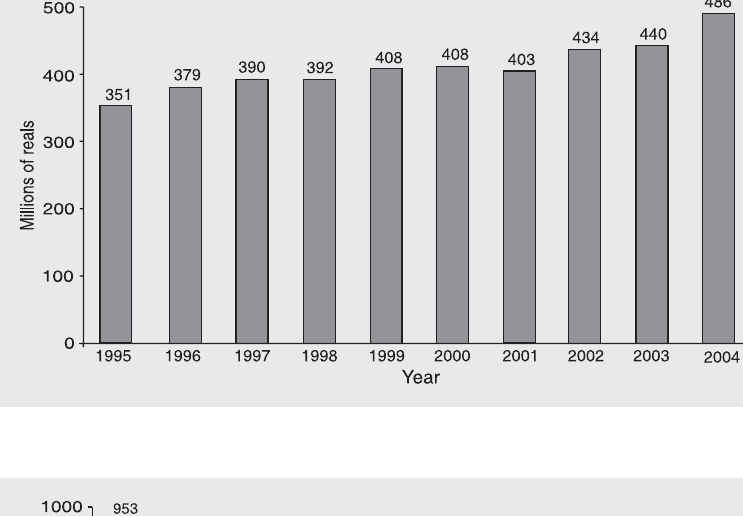
Figure 8. Funds spent by CAPES on scholarships be- tween 1995 and 2004, corrected for inflation using the IGP-DI, and considering 2004 as the reference point (original data source: CAPES, http://www.capes.gov.br/